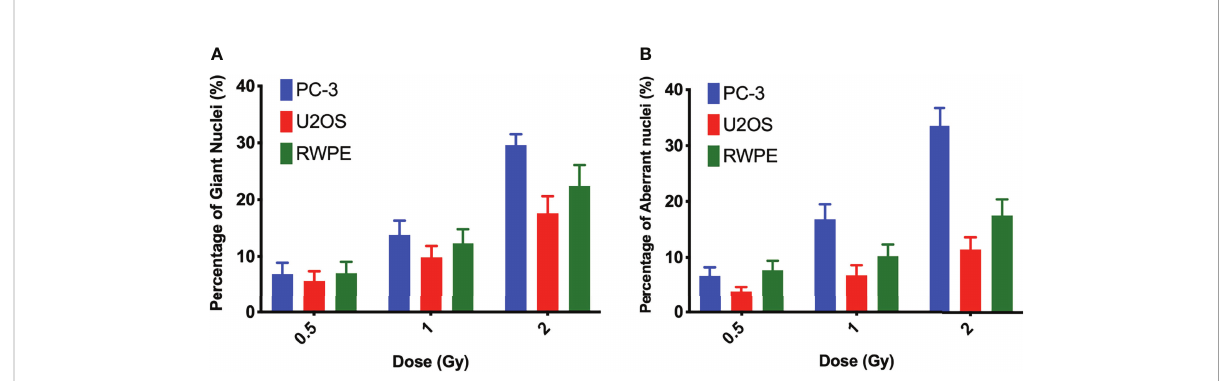
FIGURE 5 223 Ra induces mitotic catastrophe in a cell- and dose-dependent manner. Percentage of cells that have (A) a giant nucleus 24 h after irradiation or (B) an aberrant nucleus 96 h after irradiation as a function of absorbed dose. Data were obtained by microscopic evaluation of cell morphology after DAPI staining of three independent experiments with the respective standard